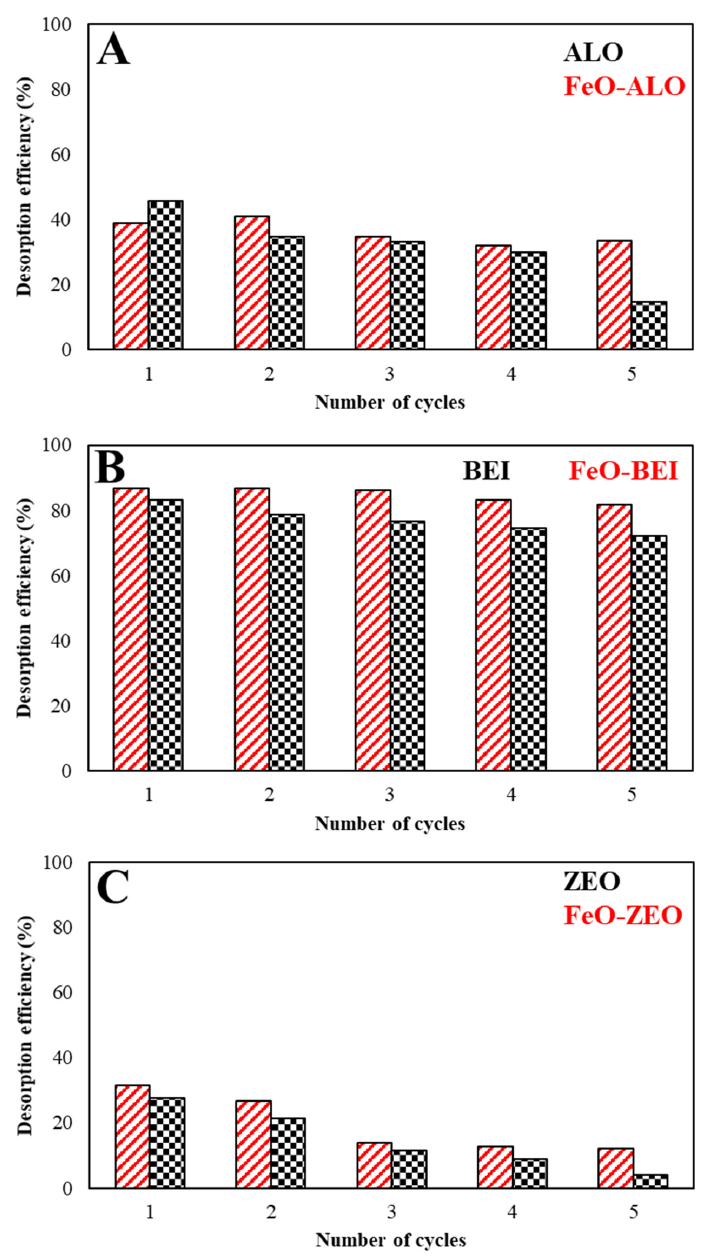
Figure 10. Regenerability (operational conditions: 298 K, pH 6.0–3.0, adsorbate / adsorbent ratio: 500:1, 10 mg/L Ba) of natural and FeO-modified ALO ( A ), BEI ( B ) and ZEO ( C ).